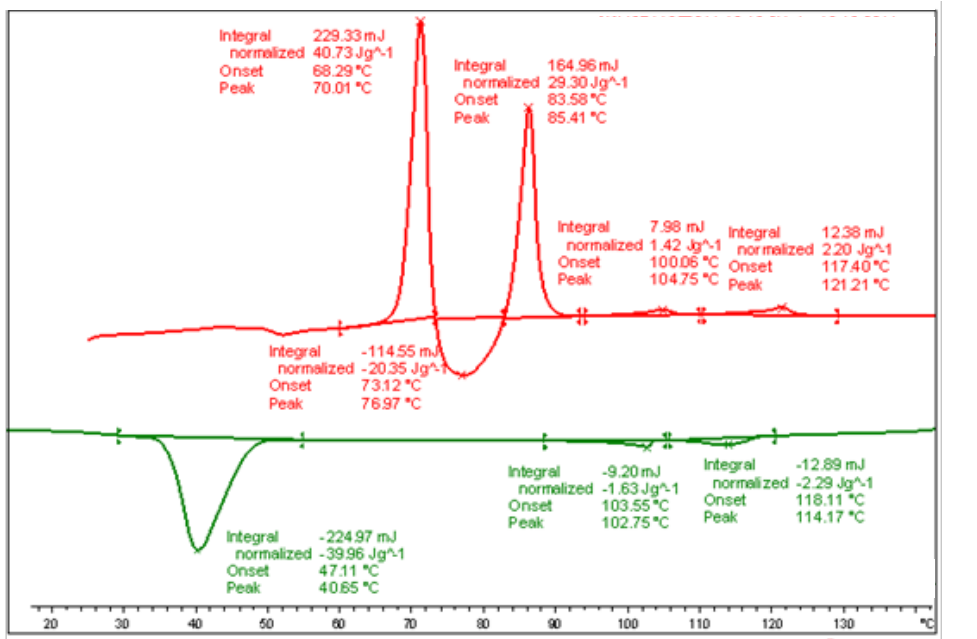
Figure 17. DSC studies (10 K/min) of the mixture, MGTP211 ; the values are taken from the first heating and cooling scans. Heating: Cr 85.4 (29.3) Nx 104.7 (1.42 ) N 121.2 (2.20) Iso. Numbers in brackets, transition enthalpies J∙g −1 . Cooling: Iso 114.2 (−2.29) N